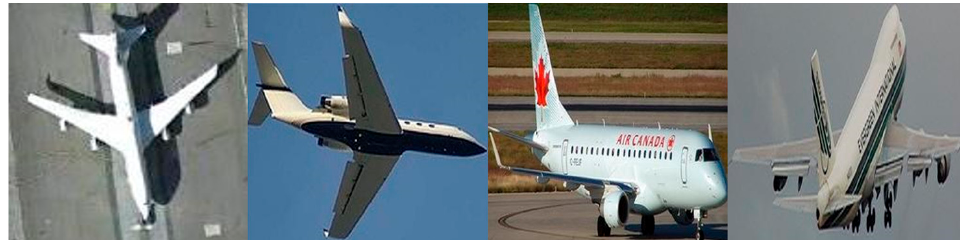
Figure 4. Multiple attitudes of the optical image on same target.